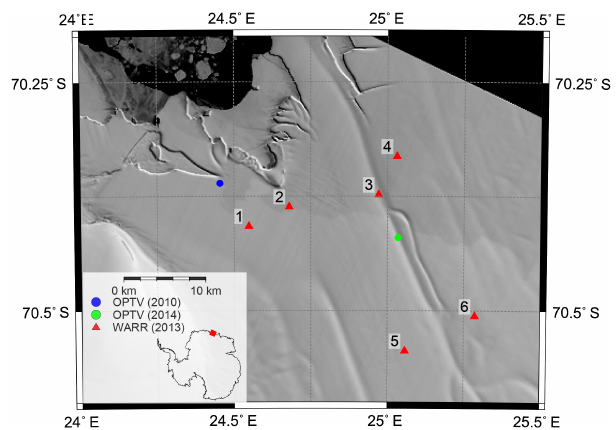
Figure 2. Location of the wide-angle (WARR) radar sites (red tri- angles) relative to the boreholes of 2010 and 2014 which were used for optical televiewing (OPTV). The depressed surfaces of ice-shelf channels appear as elongated lineations in the background image (Landsat 8, December 2013, provided by the US Geological Sur-